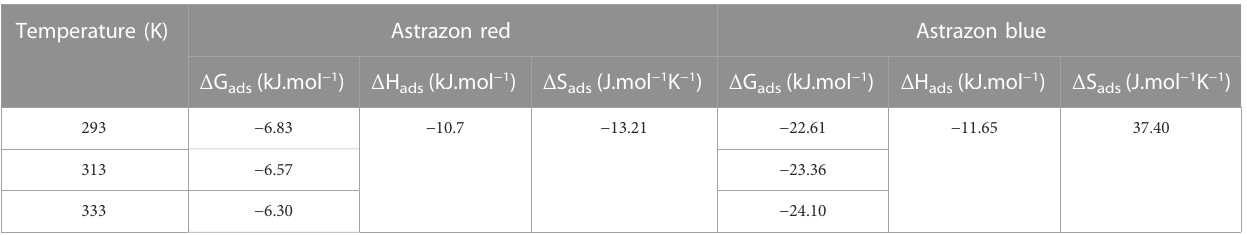
TABLE 3 The thermodynamic quantities calculated for adsorption systems. Temperature (K) Astrazon